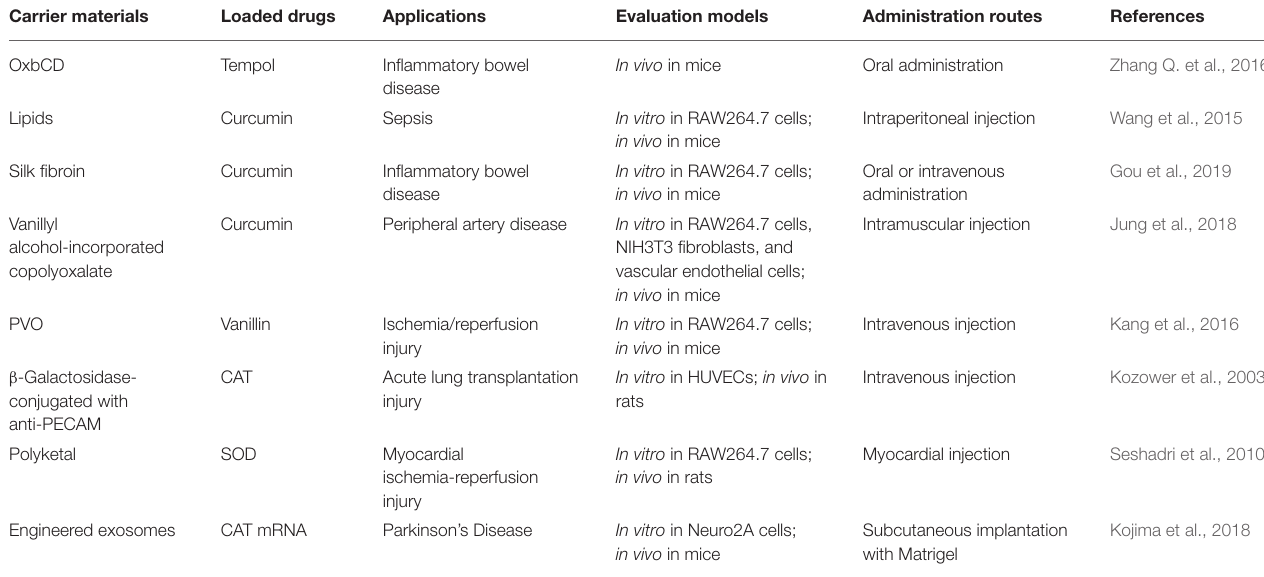
TABLE 3 | Typical drug-loaded nanoparticles with antioxidant